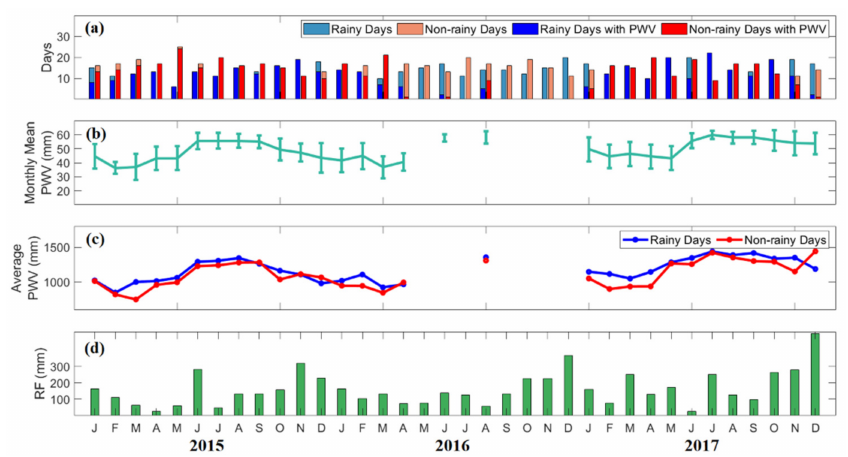
Figure 7. ( a ) The number of rainy and non-rainy days, and rainy and non-rainy days with PWV per month in Legaspi from 2015 to 2017. ( b ) The monthly mean variations of PWV for all days, ( c ) monthly average of daily PWV, and ( d ) monthly rainfall are also presented. The color scales are in Figure